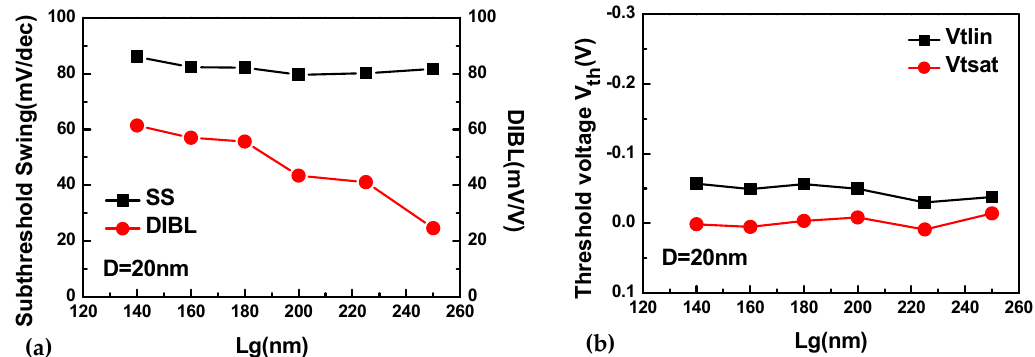
Figure 9. ( a ) Transfer characteristic; ( b ) output characteristic of P-type triangular GAA SNWT with D = 20 nm and L g = 140 nm.